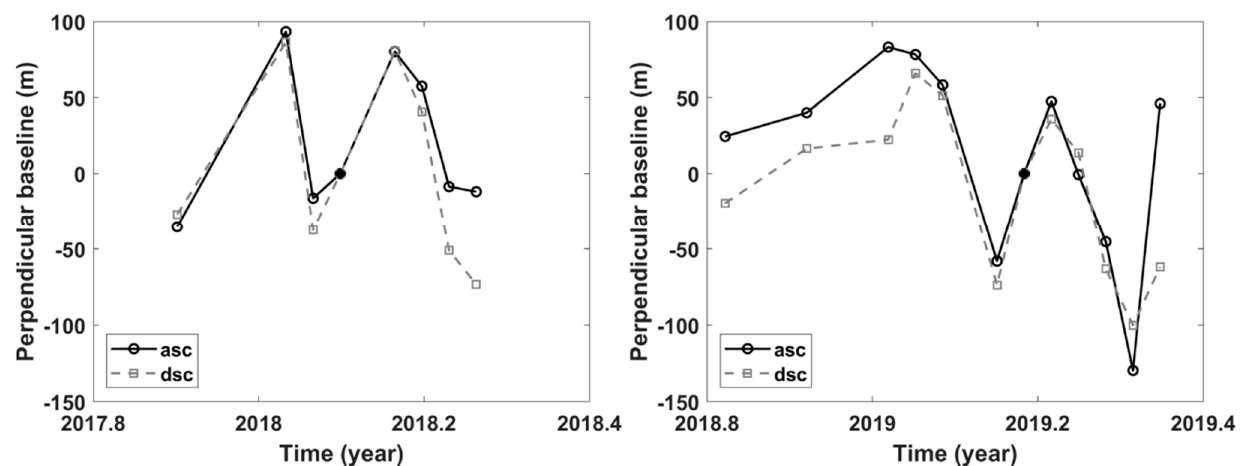
Figure 3. Perpendicular and temporal baseline plots of Sentinel-1 SAR datasets in Table 1 (left: 2017–2018 cycle, right: 2018–2019 cycle). The filled markers represent the master images.